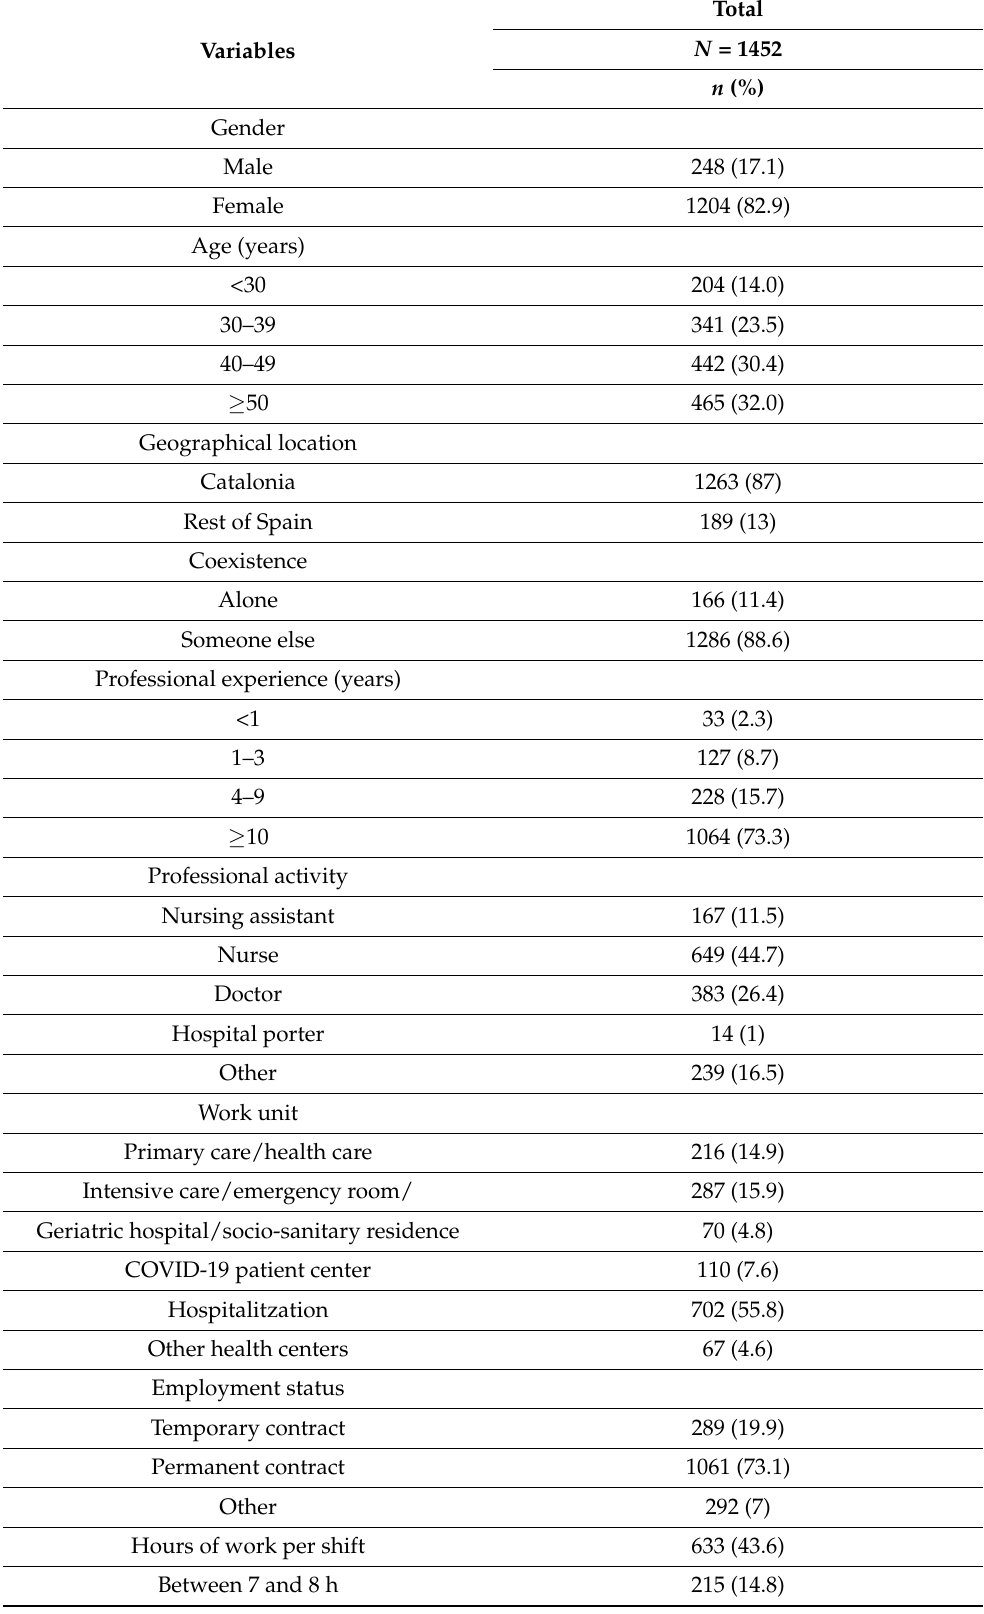
Table 2. Sociodemographic and professional characteristics of